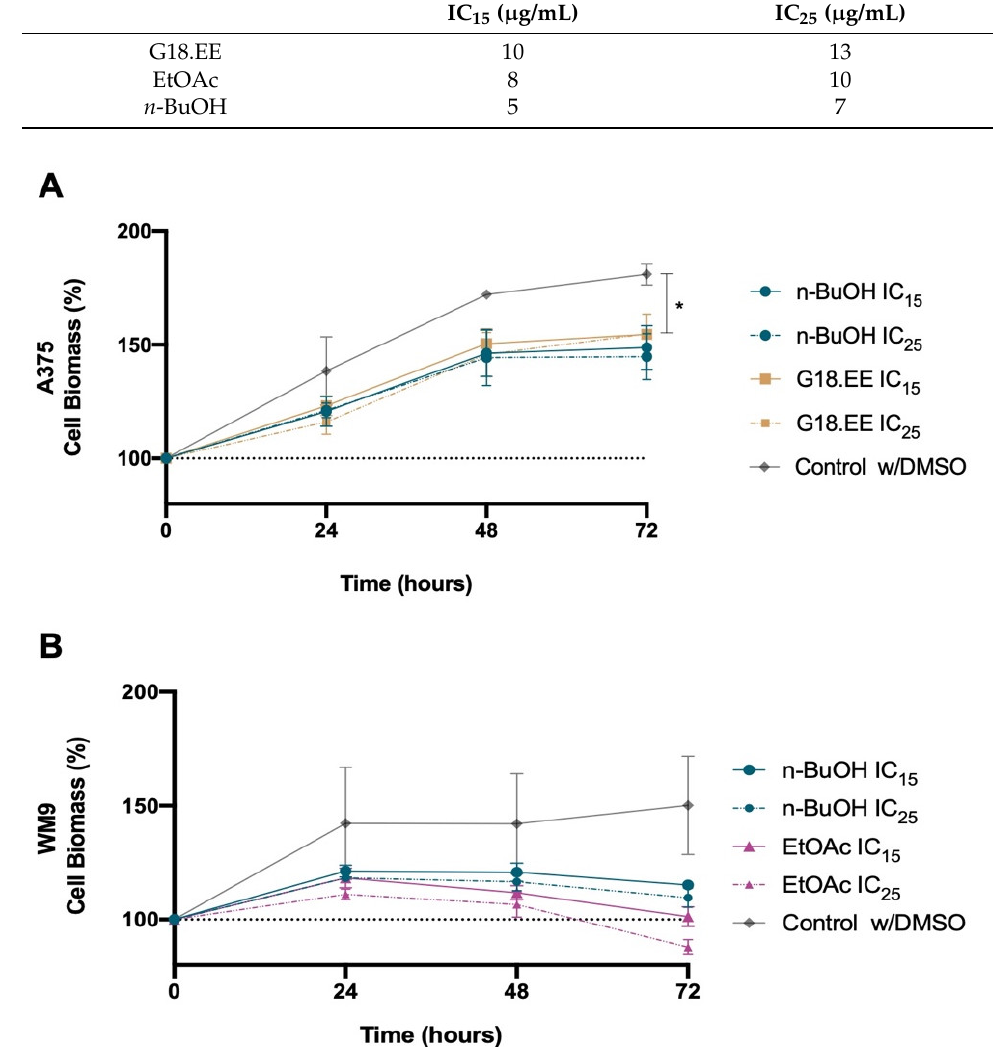
Figure 2. Effect of the two selected concentrations of propolis fractions on cell biomass (A375 and WM9 cells) over time. Cell biomass was measured at 24, 48, and 72 h by SRB assay after treatment with ( A ) 5 µ g/mL (IC 15 ) and 7 µ g/mL (IC 25 ) n -BuOH and 10 µ g/mL (IC 15 ) and 13 µ g/mL (IC 25 ) G18.EE for A375 cell line; ( B ) 5 µ g/mL (IC 15 ) and 7 µ g/mL (IC 25 ) n -BuOH and 8 µ g/mL (IC 15 ) and 10 µ g/mL (IC 25 ) EtOAc for WM9 cell line. A375 and WM9 cells treated with DMSO were used as controls. Results are expressed as mean ± SD. Three independent experiments were carried out in triplicate. * p <